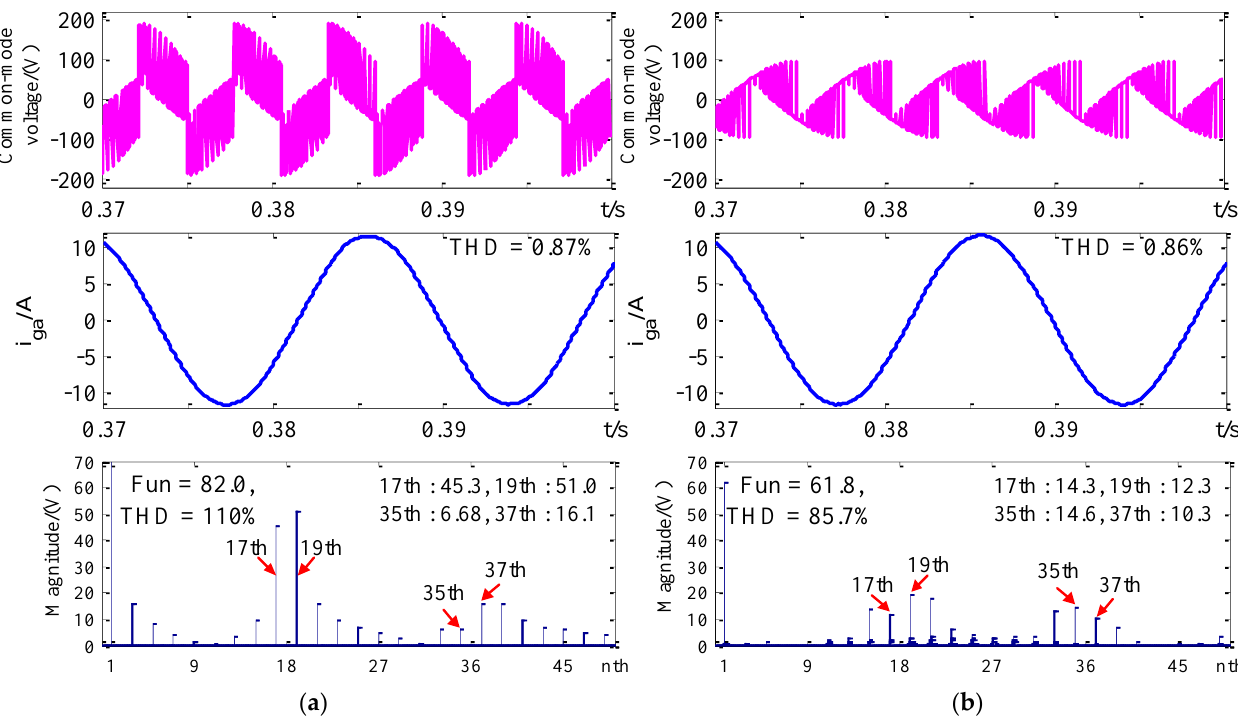
Figure 10. CMV and 𝑖 𝑔𝑎 ( 𝑚 𝑎 = 0.833 and 𝜙 = 30 ° ): ( a ) SVM1 and ( b ) SVM2. Figure 10. CMV and i ga ( m a = 0.833 and φ = 30 ◦ ): ( a ) SVM1 and ( b ) SVM2.